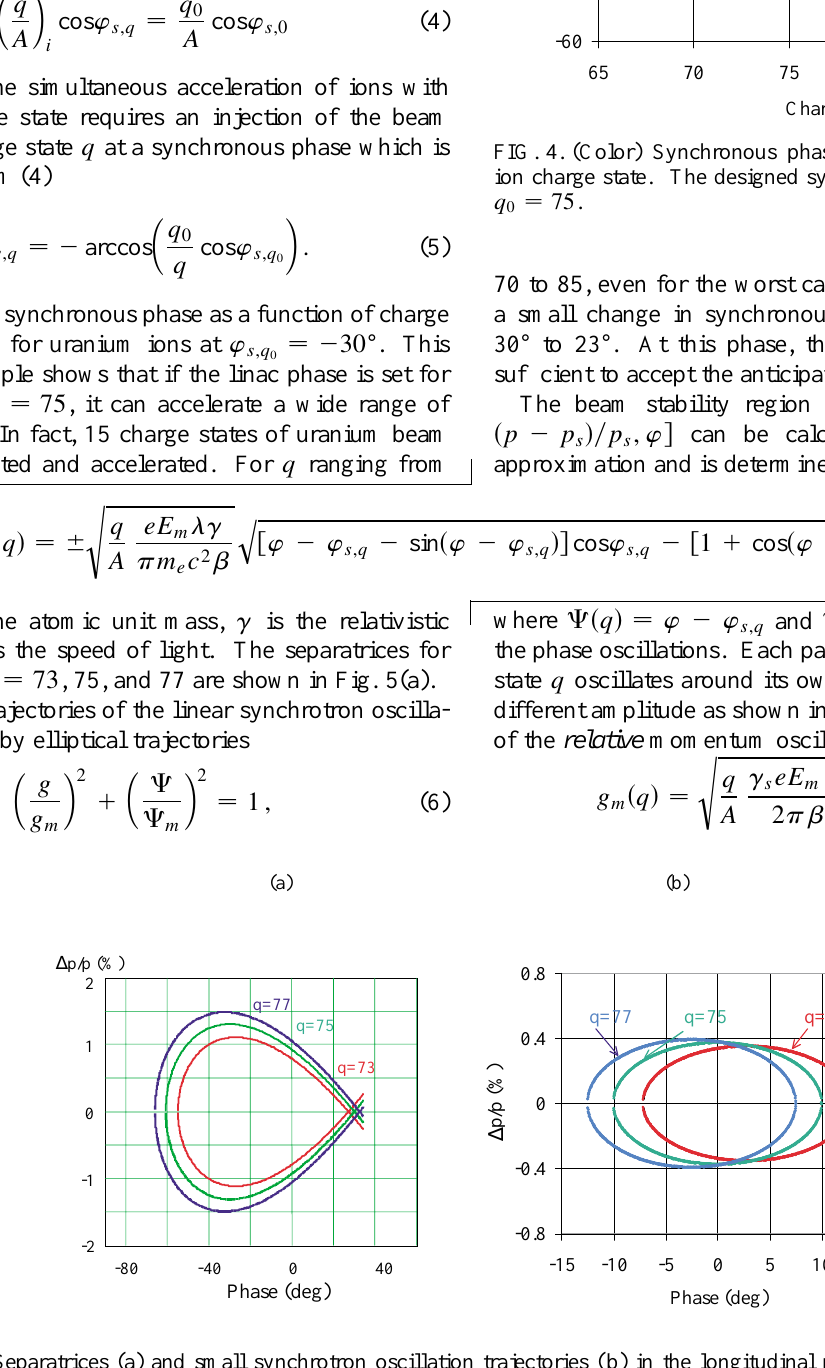
FIG. 5. (Color) Separatrices (a) and small synchrotron oscillation trajectories (b) in the longitudinal phase space for charge states 73, 75, and 77 of uranium